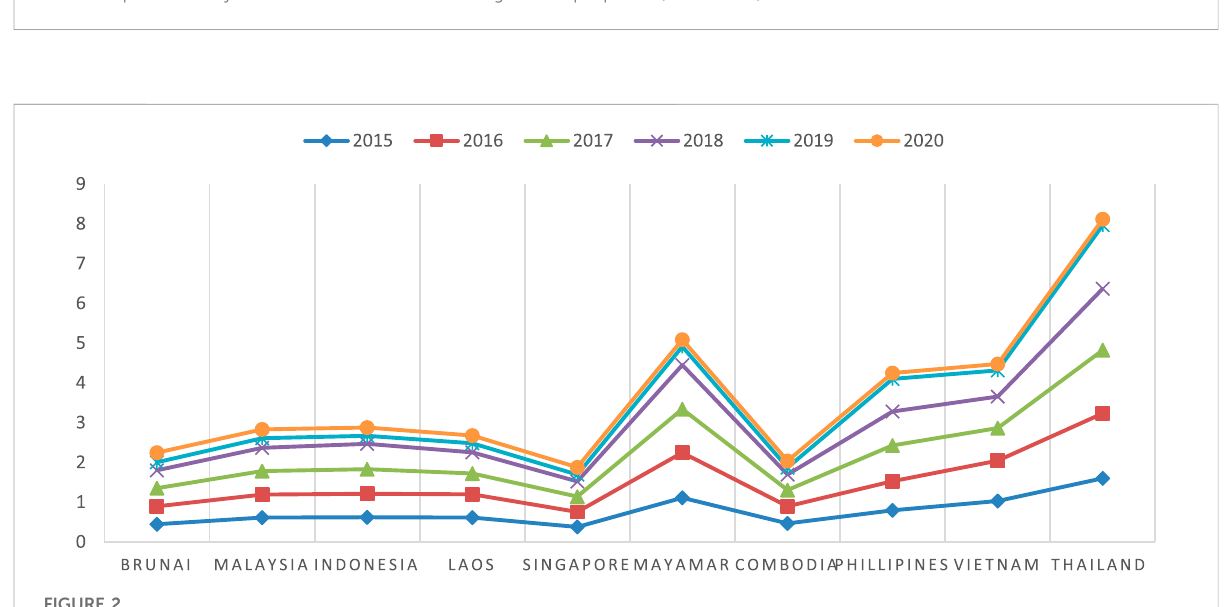
FIGURE 2 Energy production change concerns movements in ASEAN